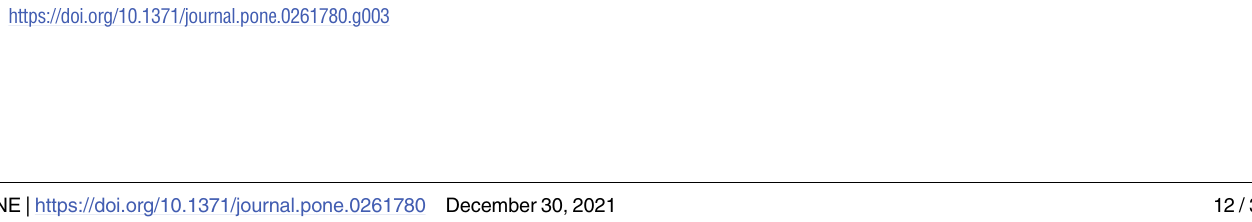
PLOS ONE | https://doi.org/10.1371/journal.pone.0261780 December30,